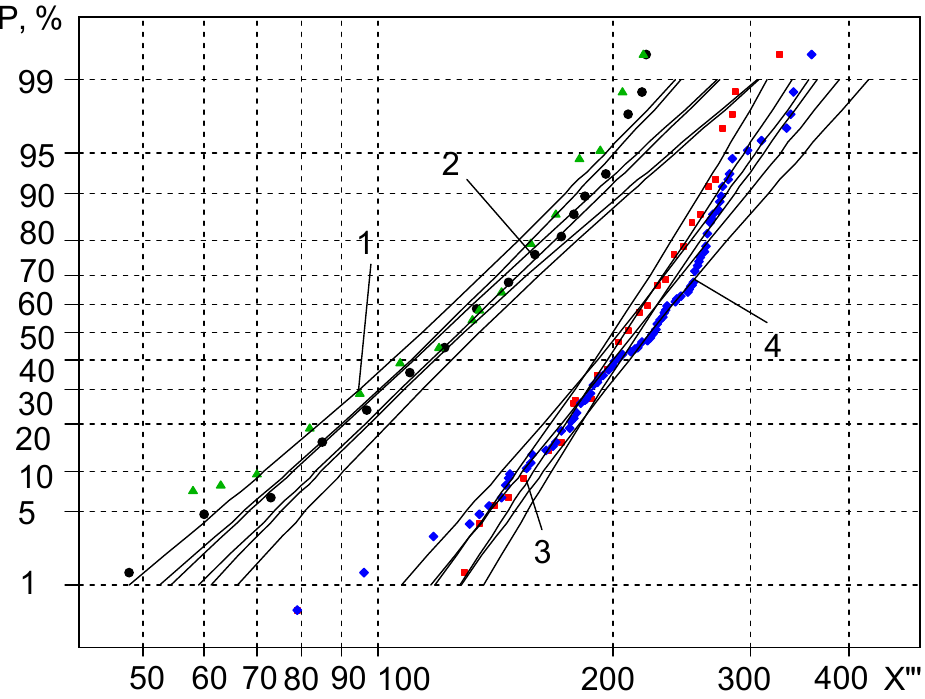
Figure 8. Statistical distribution curves for the mechanical properties of steel D16T with identified sensitivity thresholds N 0 and N k (1— σ y , 2— σ pr , 3— σ u , 4— S k